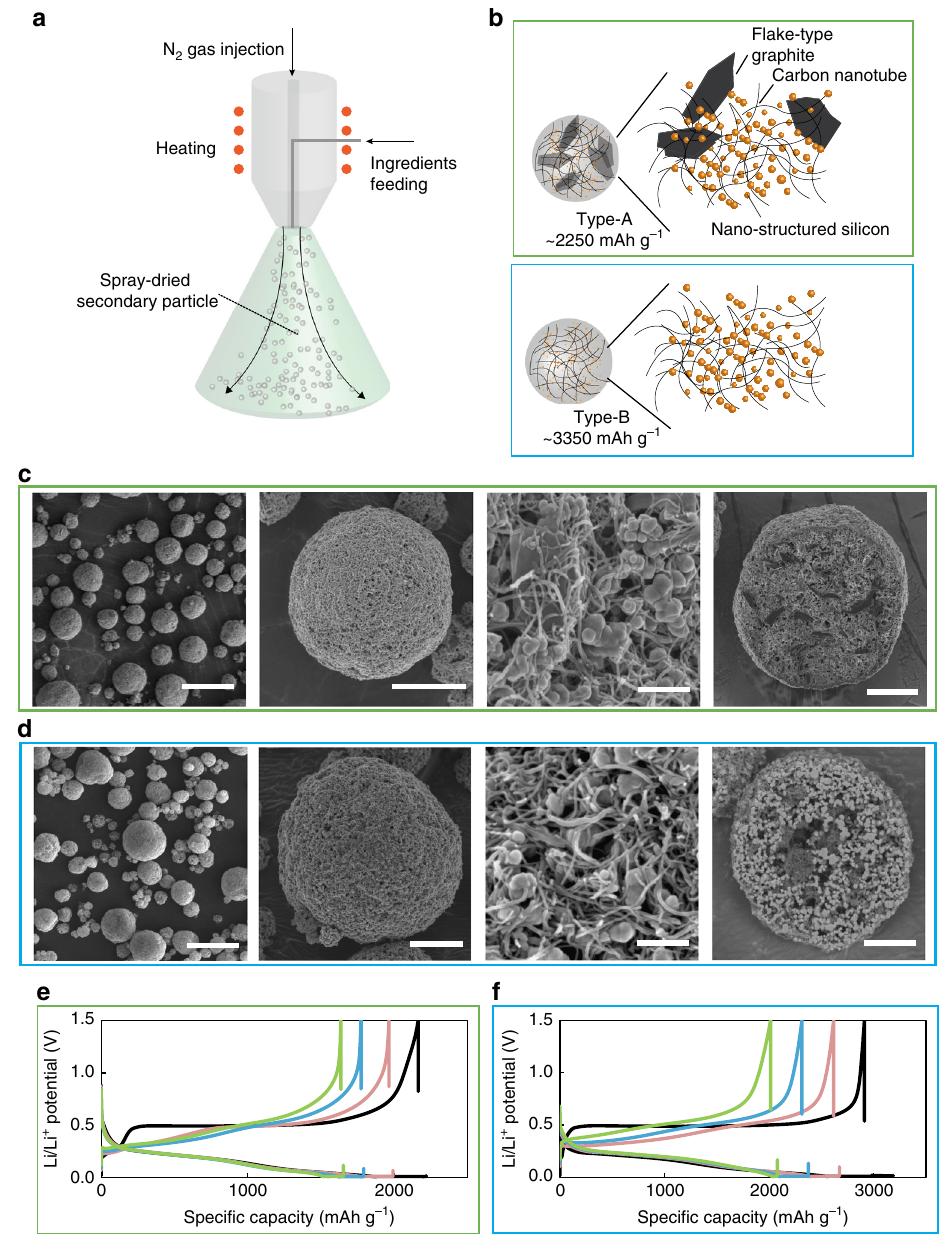
Fig. 2 Preparation of active materials with different Si concentrations. Schematic of ( a ) the spray-drying process for secondary particle fabrication and ( b ) spray-dried type-A and -B secondary particles (with the fi rst reversible capacity being 2250 and 3350 mAh g − 1 , respectively) as active materials. Particles with two different Si concentrations are used in this study to con fi rm consistency of the electrochemical outputs with different Si concentrations. For more detailed material properties for these particles see Supplementary Table 4. The schematics for type-A and -B are surrounded by green and blue empty rectangles in ( b ), respectively. SEM/BSE images of ( c ) type-A and ( d ) type-B secondary particles. The three images on the left in ( c , d ): planar views by SEM with different magni fi cations, on the right in ( c , d ): FIB cross-sectional views by BSE. The scale bars in the images (from left to right) in ( c , d ) are 20 µ m, 5 µ m, 200 nm, and 5 µ m, respectively. ( e , f ) Li/Li + potential as a function of speci fi c capacity on the 10 th cycle for different capacity-cutoff depth of discharge (DOD) percentages for ( e ) type-A and ( f ) type-B electrodes. The black, pink, blue, and green pro fi les correspond to cycling under DOD100%, 90%, 80%, and 70%,